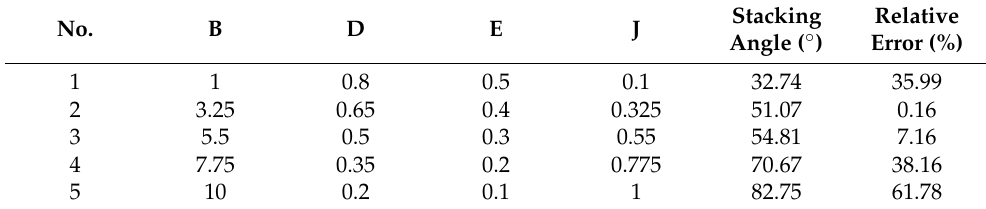
Table 4. Design scheme and results of steepest climbing test.